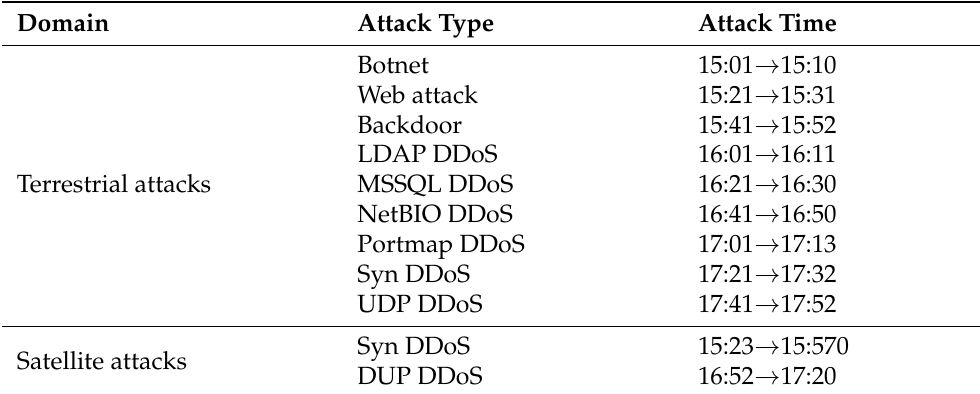
Table 4. Detail of STIN